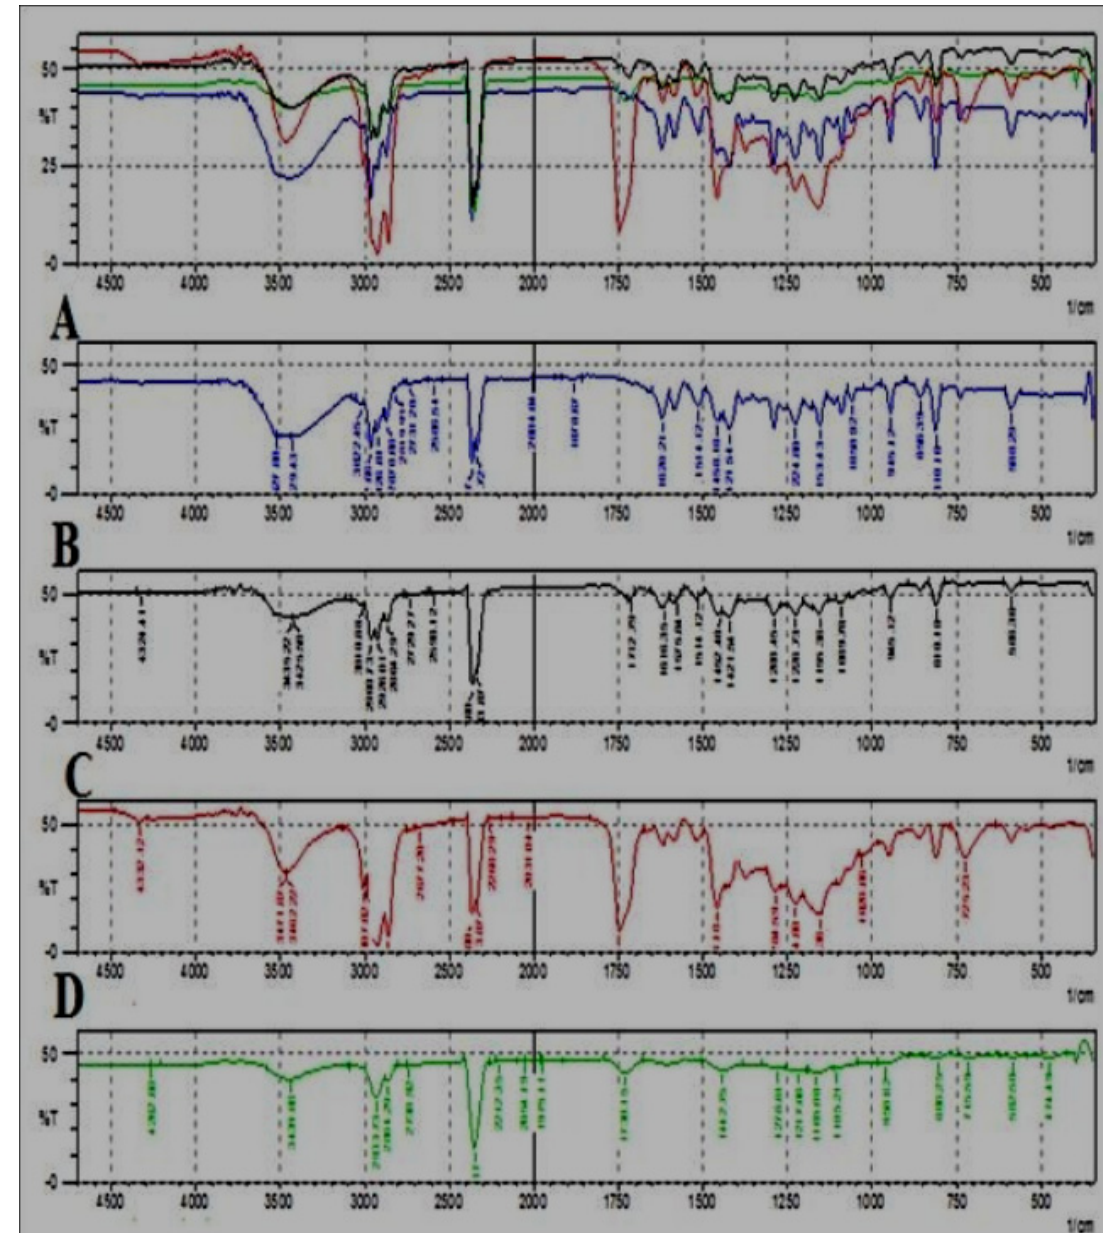
Figure 6. Comparative FTIR spectra of different oils of T. ammi L. extracted using different extraction techniques. ( A ) Hydrodistilled oil, ( B ) Solvent extracted oil, ( C ) SC-CO 2 oil, ( D ) Ultrasonicated Table 6. Results of the FTIR analysis of T. ammi oil extracted by different techniques.